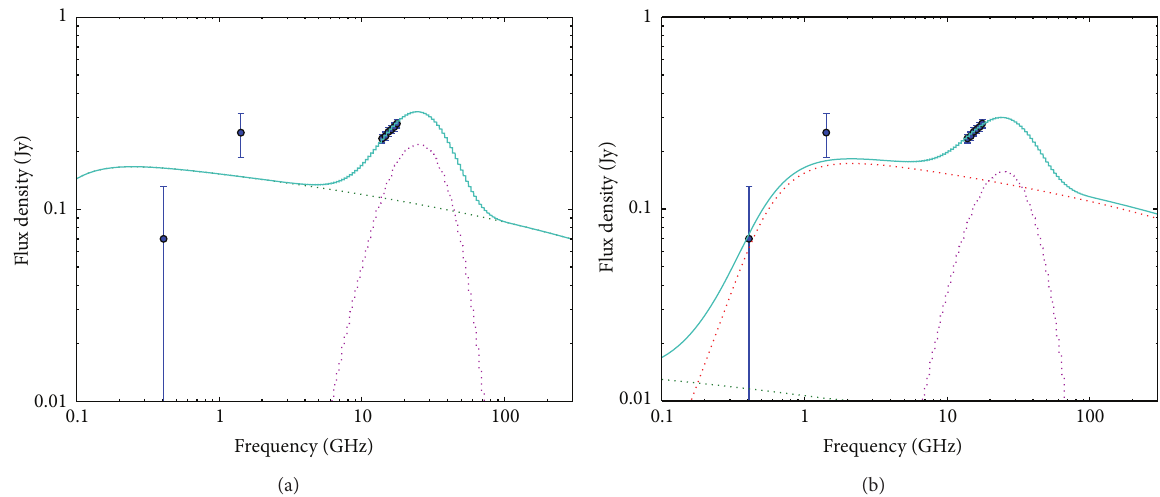
Figure 6: SED for AME-G107.1+5.2 including fluxes at 0.408 and 1.42GHz from the CGPSE catalogue normalised by the flux loss expected in AMI channel 3 and the flux-loss-corrected AMI fluxes. (a) shows a single free-free component plus spinning dust contribution to the SED; (b) shows a fit to the flux densities using a two-component free-free model plus a spinning dust contribution. Please see the text for details.